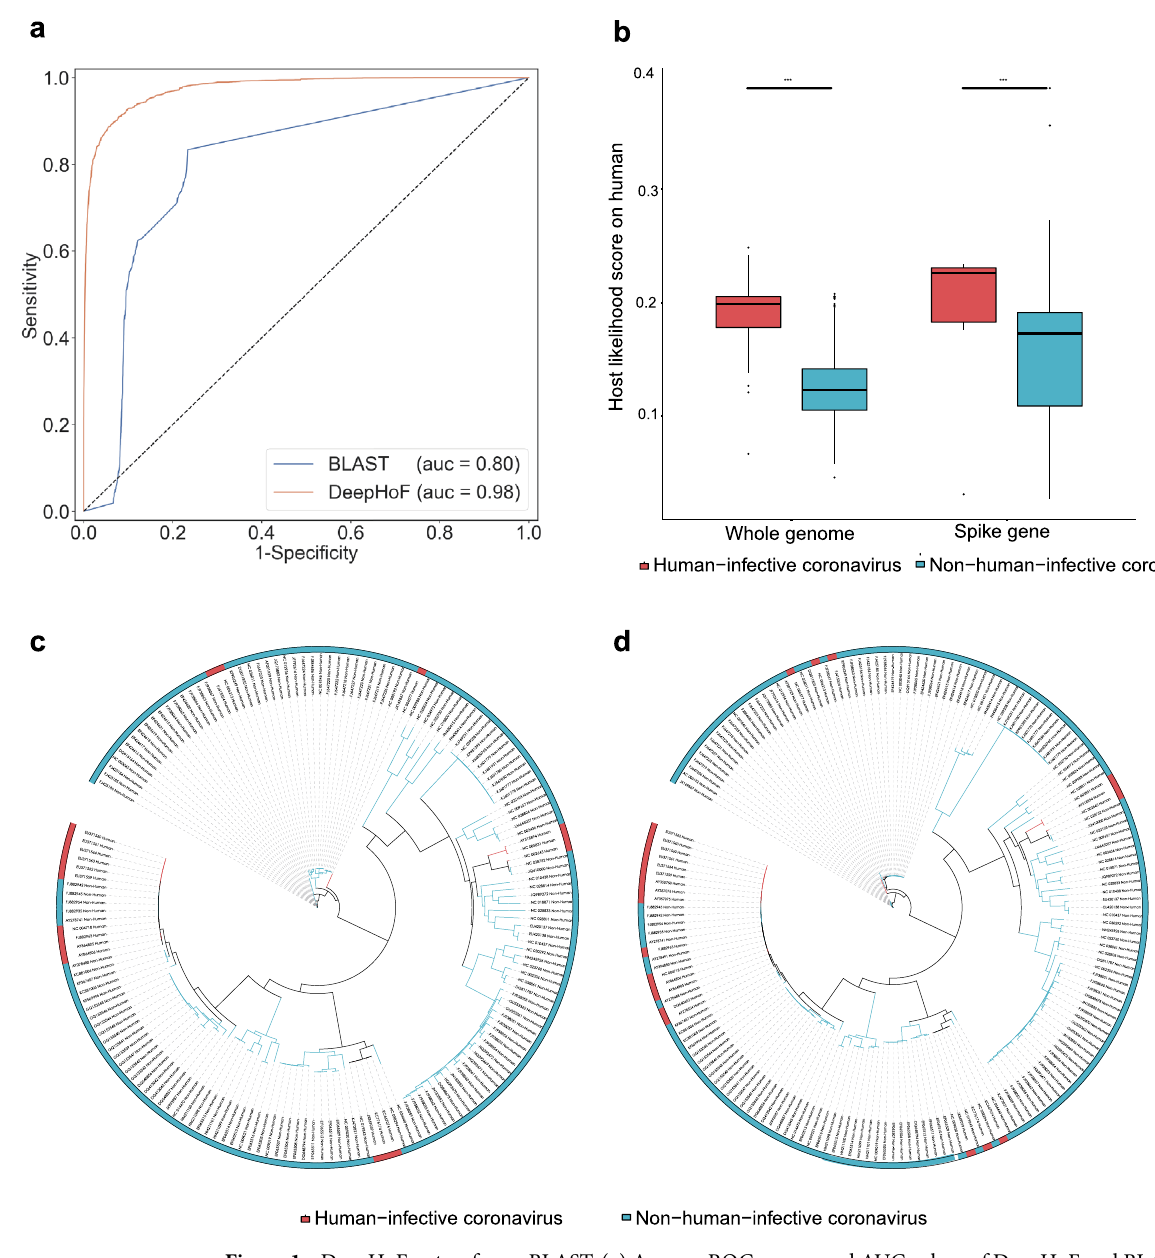
(a detailed comparison on each host type is shown in Supplementary Fig. S1; Table S1).